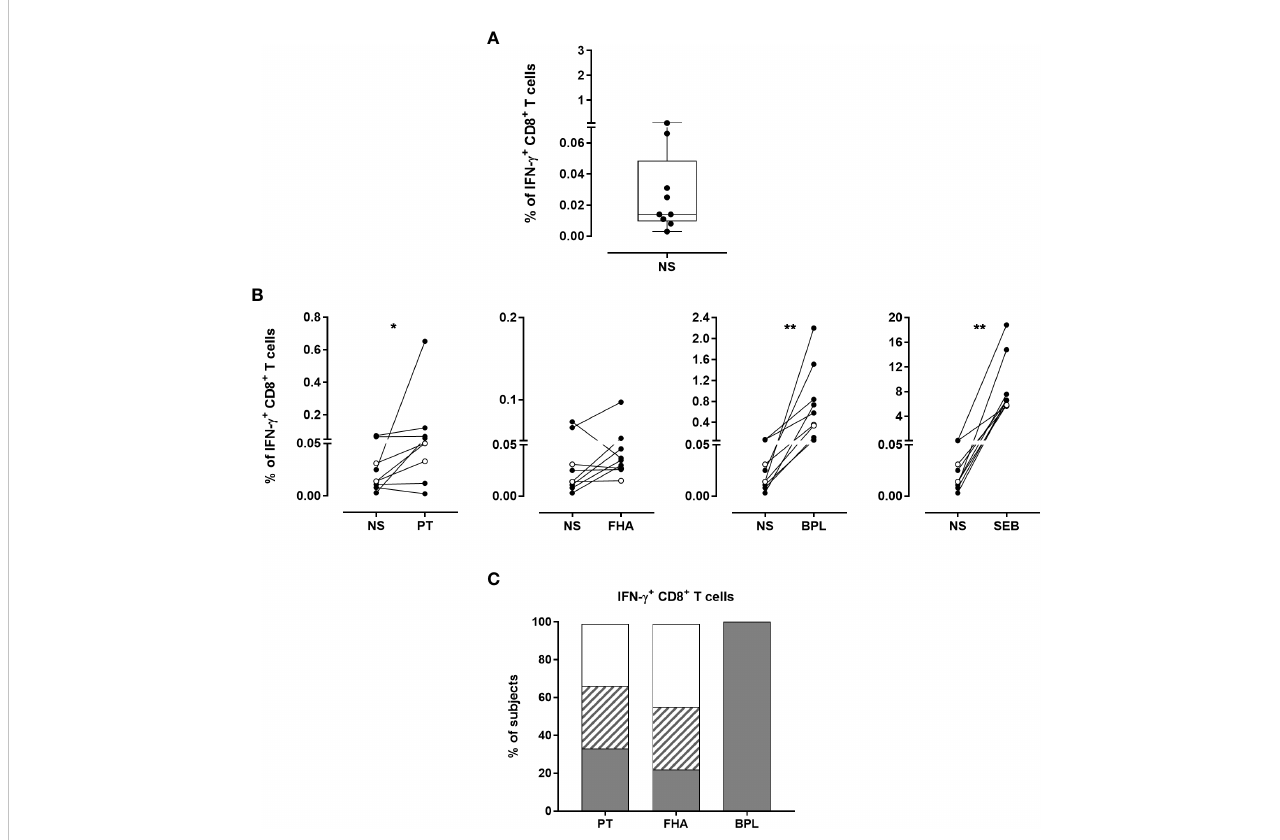
FIGURE 8 Detection of Bp antigen-speci fi c IFN- g -producing CD8 + T lymphocytes. The presence of IFN- g -producing CD8 + T cells was investigated following the same procedure as described in Figure 5. The analysis was performed for seven adults (n°6-12) and two 5-6 years-old children, all recently aP vaccine boosted. (A) Non-speci fi c background of IFN- g -producing CD8 + T cells was determined after 24 hrs incubation in the absence of antigen (NS). The cryopreserved cells were processed for intracellular staining as described in Figure 5, and were stained with antibody panel 2 (Table 1). Horizontal line within the box, box and whisker represent the median, the P25-P75 and the range, respectively. (B) The percentages of IFN- g -producing CD8 + T cells obtained after staining of PT-, FHA-, BPL- or SEB-stimulated cryopreserved blood cells were compared to those obtained in absence of antigen (NS). Black and open circles represent the results obtained from adult and children samples, respectively. The Wilcoxon matched-pairs signed rank test with Graphpad Prism 7.03 software was used for statistical analysis. * p <0.05; ** p <0.01. (C) The percentages of responders (grey areas), doubtful responders (hatched areas) and non-responders (white areas) to PT, FHA and BPL are based on IFN- g -producing CD8 + T cells after background subtraction. The criteria shown in Table 2 were applied for the classi fi cation in responders, doubtful responders and